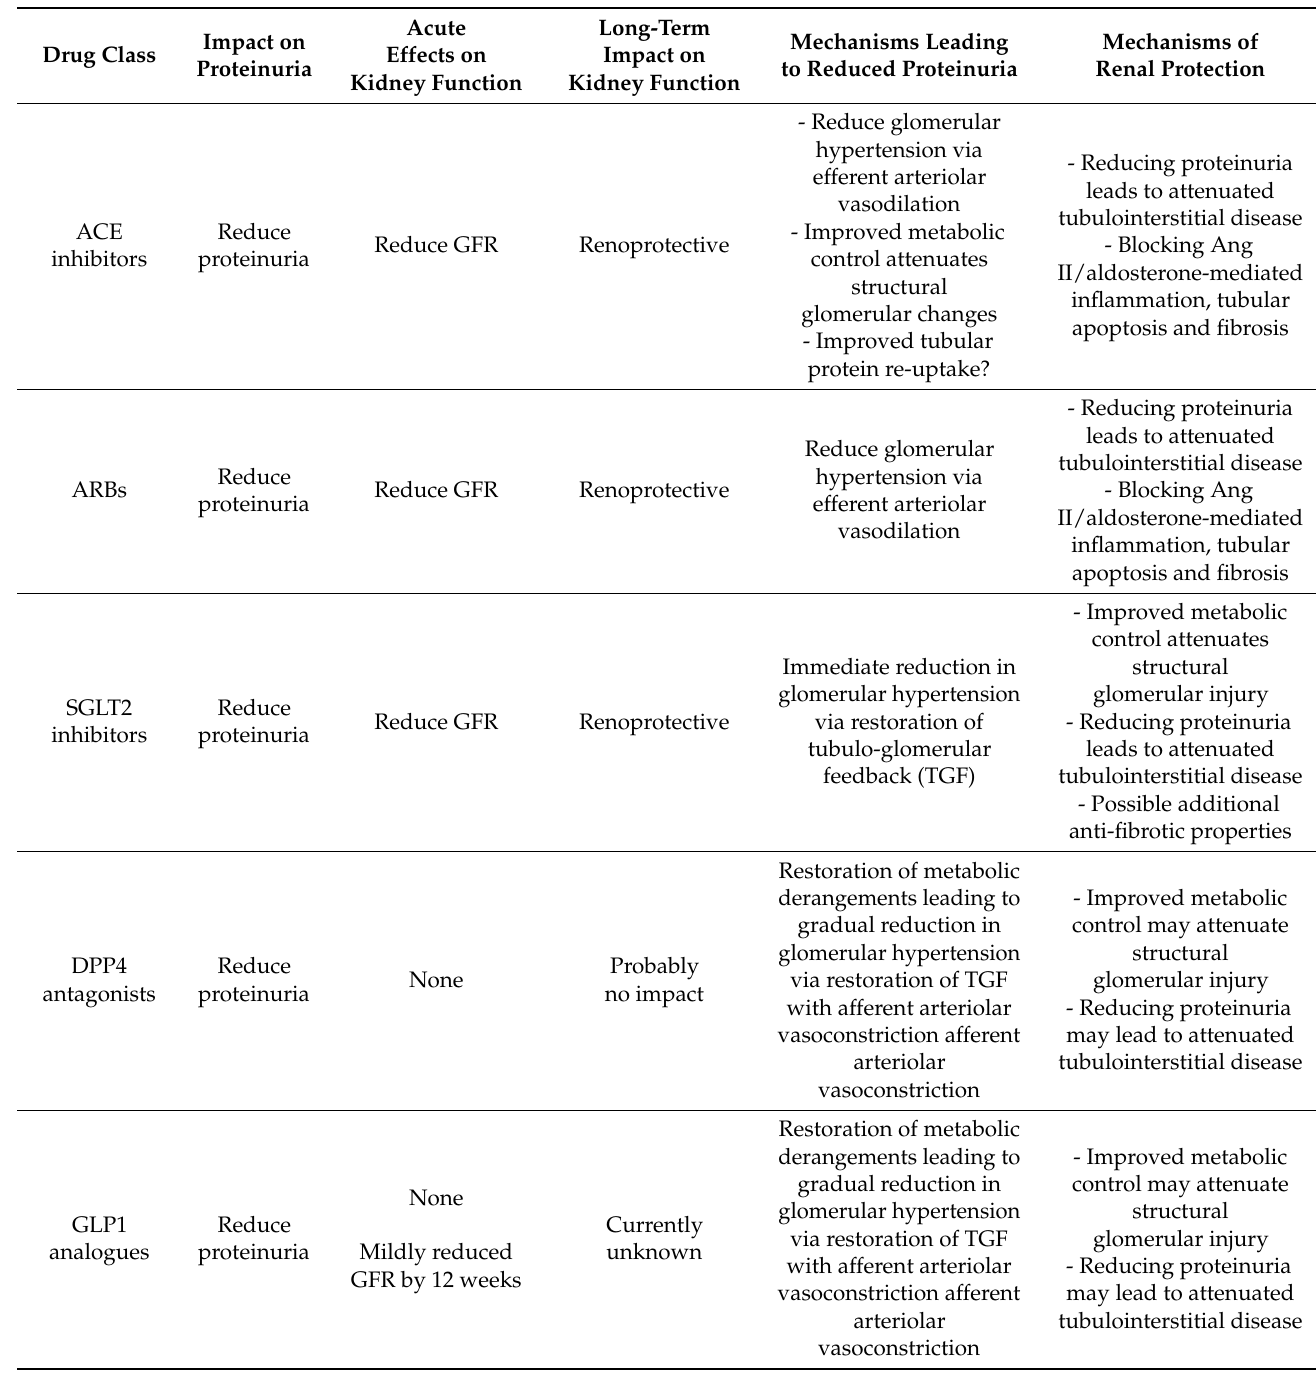
Table 1. Pharmaceutical interventions in the management of diabetic kidney